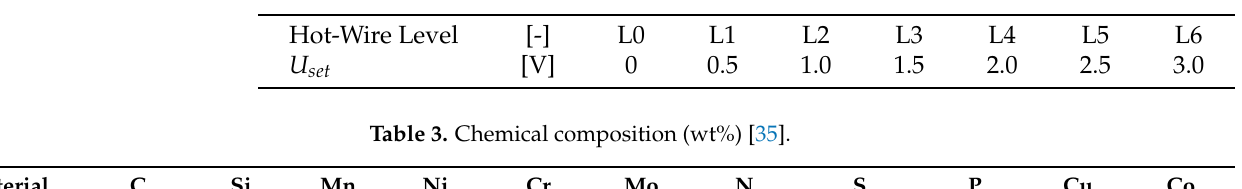
Table 2. Selected levels of the set voltage U set and corresponding hot-wire levels.